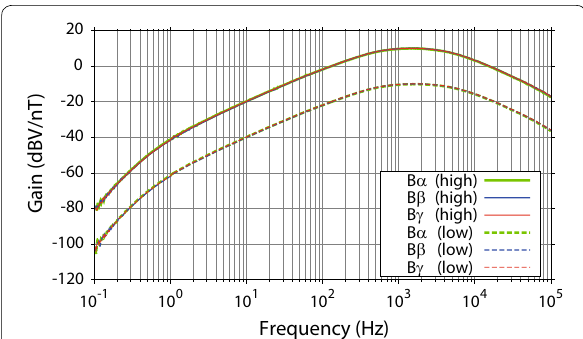
Fig. 7 Gain measurement results for the outputs of the MSC-PA in dBV/nT (0 dBV/nT 1 V/nT) =